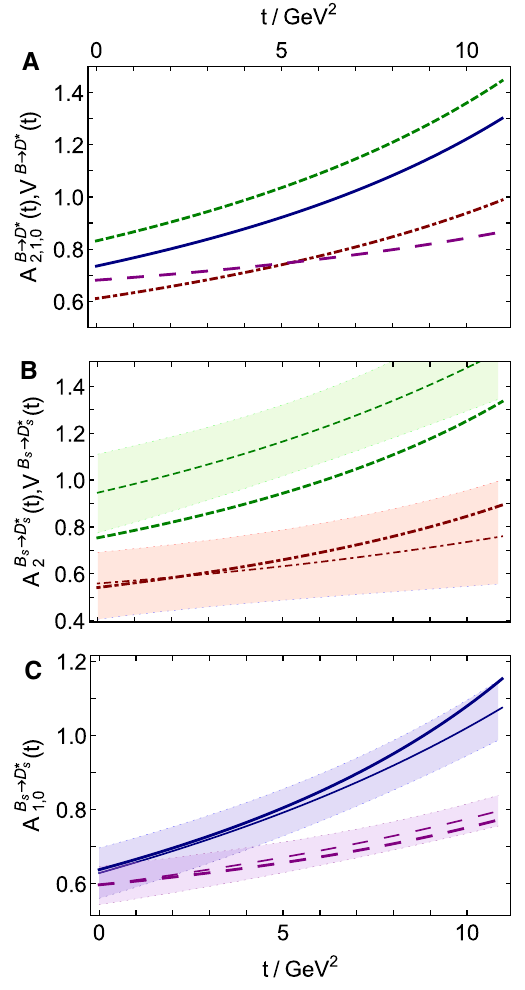
Fig. 5 A SCI predictions for B 0 → D ∗ transition form factors: A 2 ( t ) – dot-dashed red curve; A 1 ( t ) – long-dashed purple; A 0 ( t ) – solid blue; V ( t ) – dashed green. B B s → D ∗ s transition form factors: A 2 ( t ) – dot- dashed red curve; V ( t ) – dashed green. Panel C . B s → D ∗ s transition form factors: A 1 ( t ) – long-dashed purple curve; A 0 ( t ) – solid blue; in B and C , the thinner, like-texture and -colour curves within shaded bands are lQCD results from Ref.